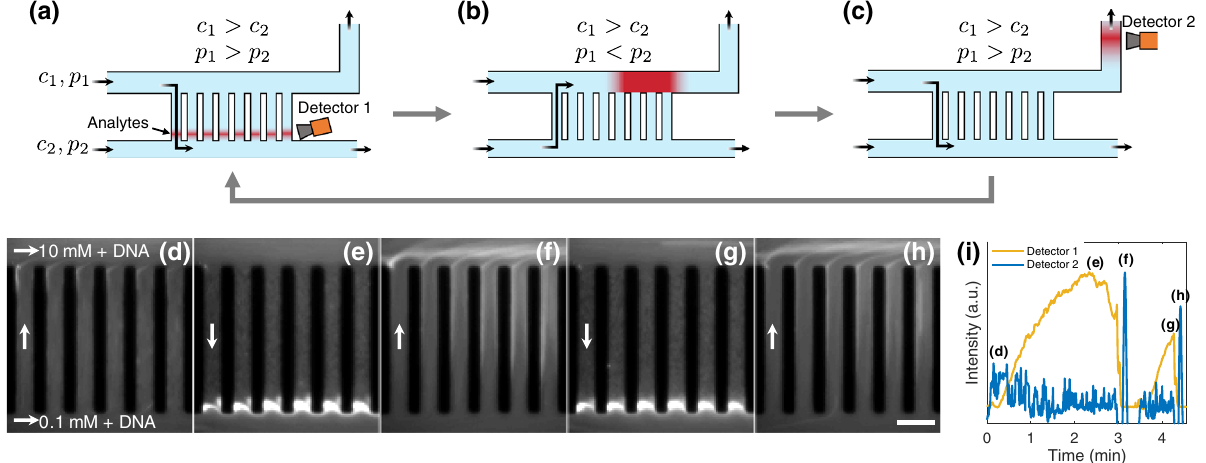
FIG. 5. Automated sample preconcentrator for a rapid bioassay. (a – c) A conceptual schematic of the preconcentrator using the flow- induced diffusiophoretic accumulation. An array of pores operates as a trap for the analytes. (a) Upon initiation of the outflow through the pores due to the higher pressure p 1 at the upper channel than at the lower channel ( p 2 ), the dilute analytes are rapidly concentrated near the flow junctions, and a stable detection can be made in this region. (b) The accumulated analytes can be transferred to the other side of the channel by changing the pressure difference across the pores for further mixing with some other chemicals or for flow-based detection. (c) Subsequently, the analytes can be analyzed at the downstream. (d – h) Experimental results showing fluorescence image sequence of preconcentration and transfer of λ -DNAs using the flow-induced diffusiophoretic accumulation (Movie 4 in Ref. [6]). Each image corresponds to the time indicated in panel (i). The solute concentration of the upper stream is c 1 ¼ 10 mM, and the solute concentration of the lower stream is c 2 ¼ 0 . 1 mM. Both streams contain λ -DNAs. (i) Fluorescence intensity measurement near the flow junction (orange curve) and downstream in the upper channel (blue curve). The scale bar in panel (h) is 100 μ